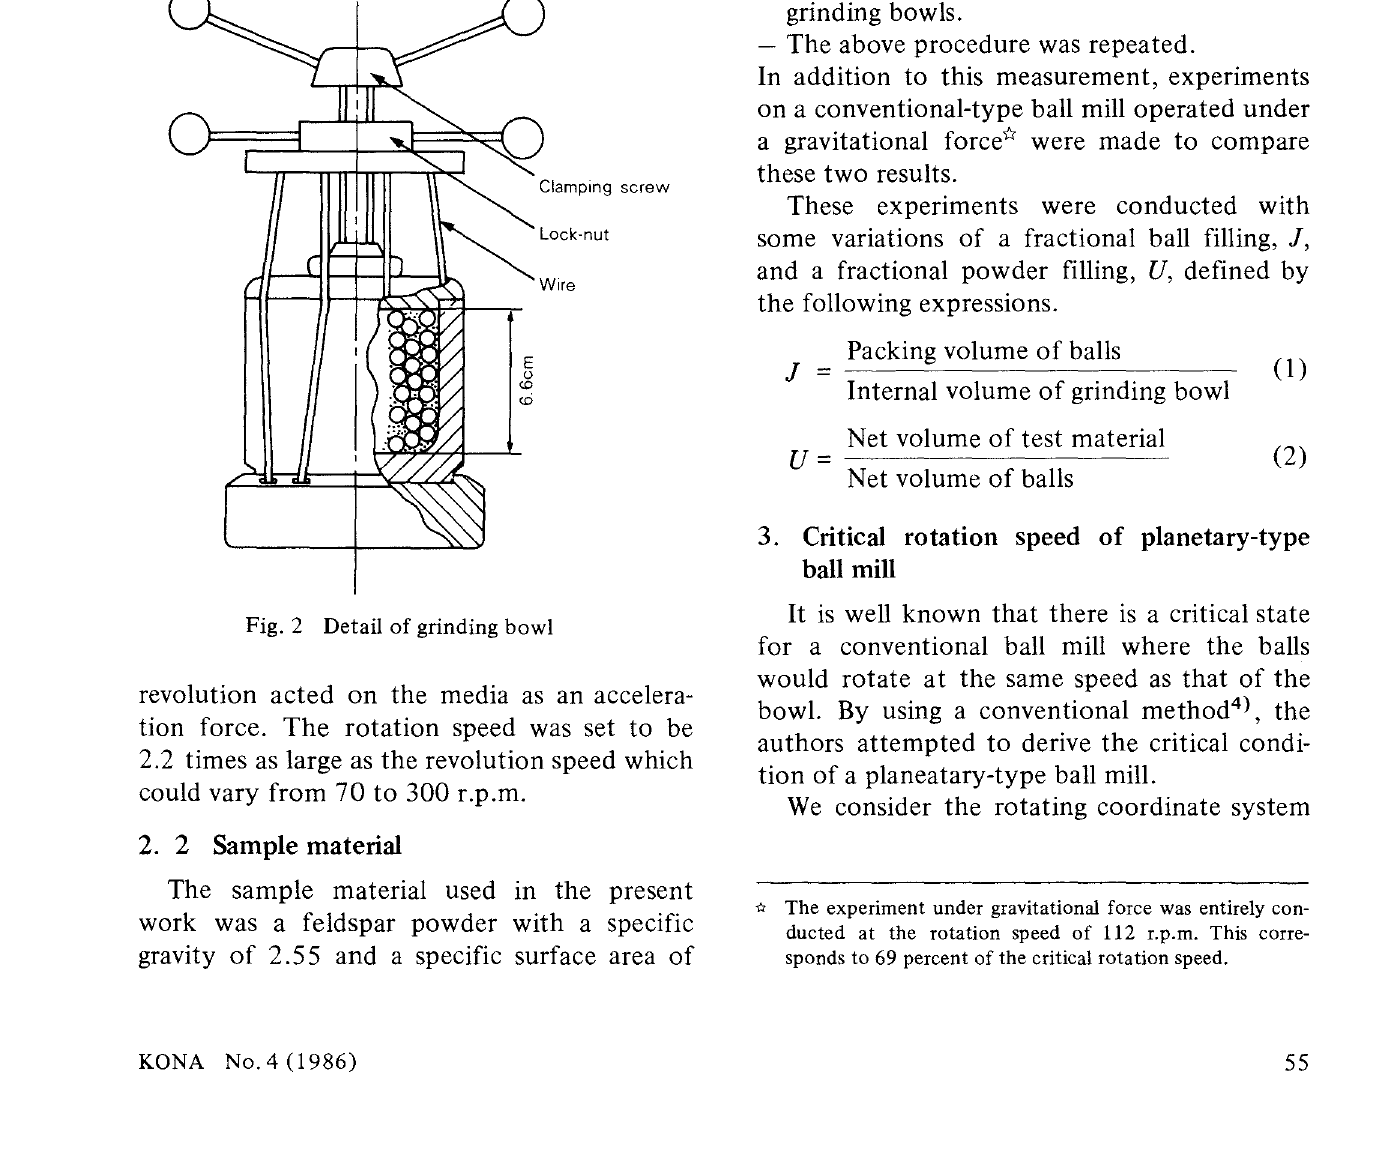
Fig. 1 Schematic diagram of a planetary-type ball